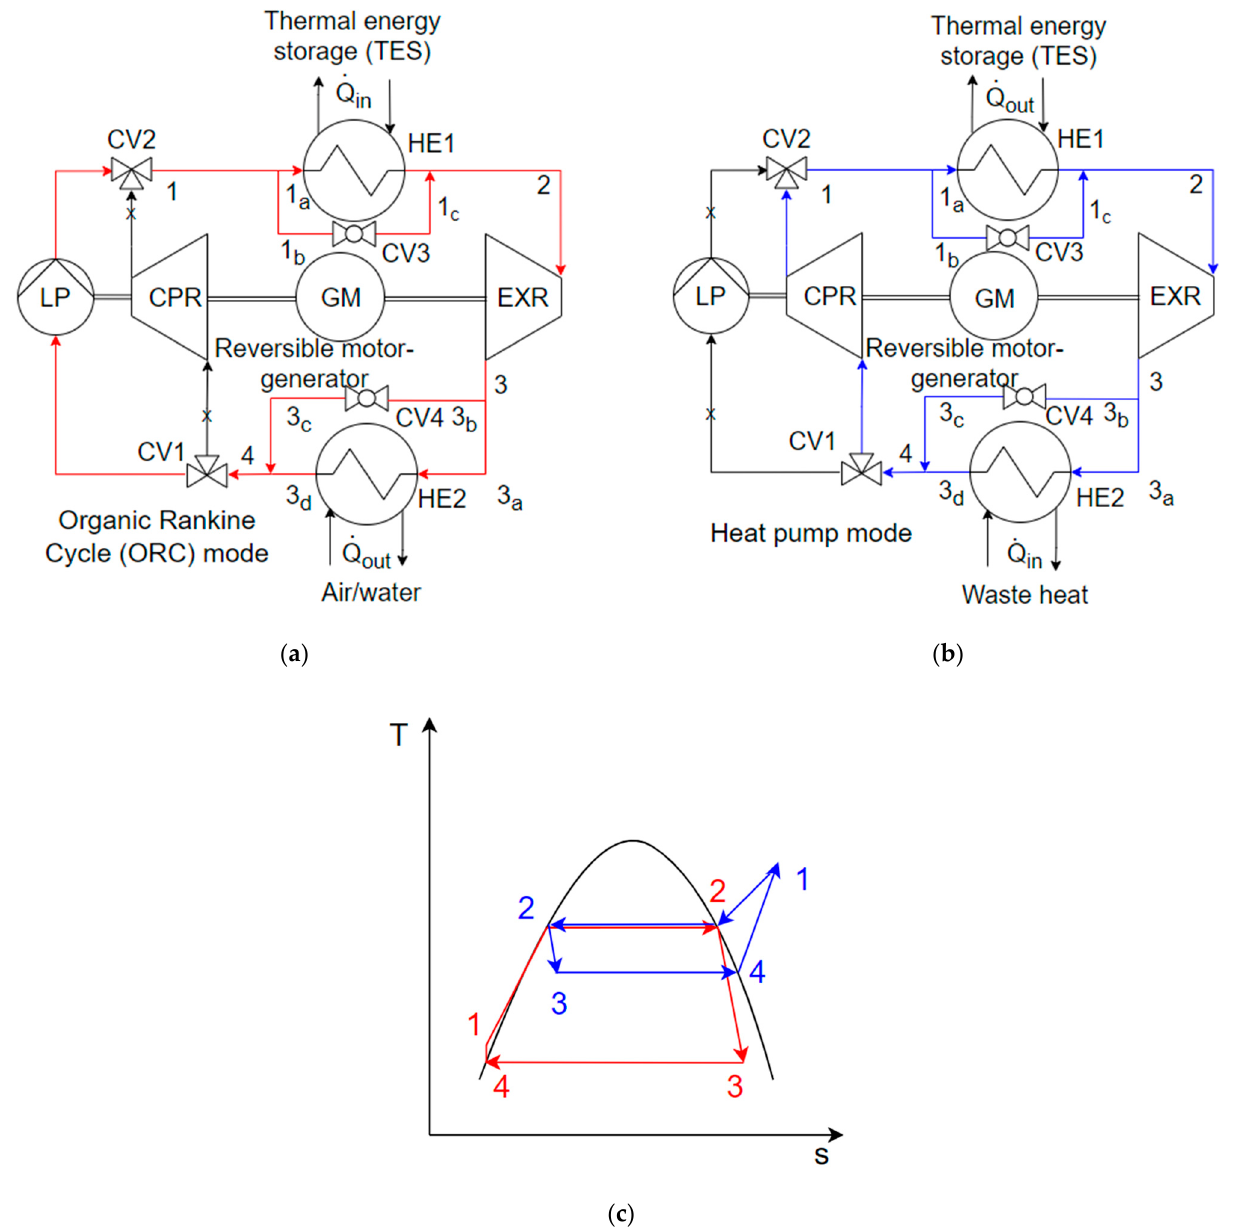
Figure 1. The proposed design of a novel reversible Rankine-based thermodynamic cycle (RRTC): the operating scheme for ( a ) the organic Rankine cycle (ORC), ( b ) the heat pump, and ( c ) its processes in a T-s diagram with the same temperature range (blue lines represent heat pump mode and red lines represent ORC mode, referring to the stream of working fluid through each component).